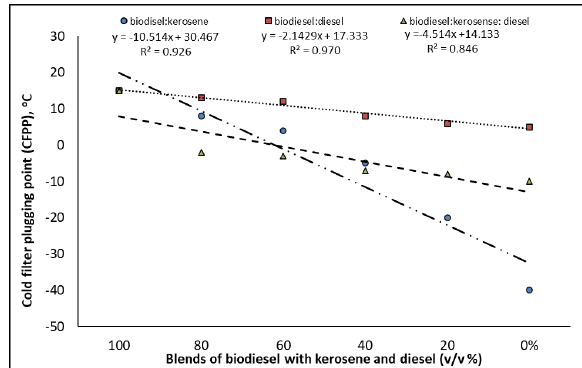
Fig. 4. Effect of Neem biodiesel ratio on CFPP of biodiesel: kerosene, biodiesel: diesel and biodiesel:kerosene:diesel blends.